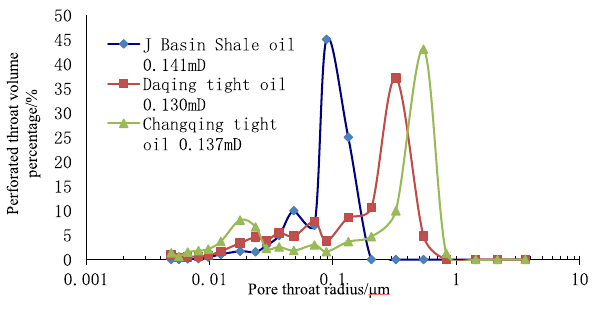
Fig. 8 Comparison of pore throat radius distribution of shale oil and tight oil